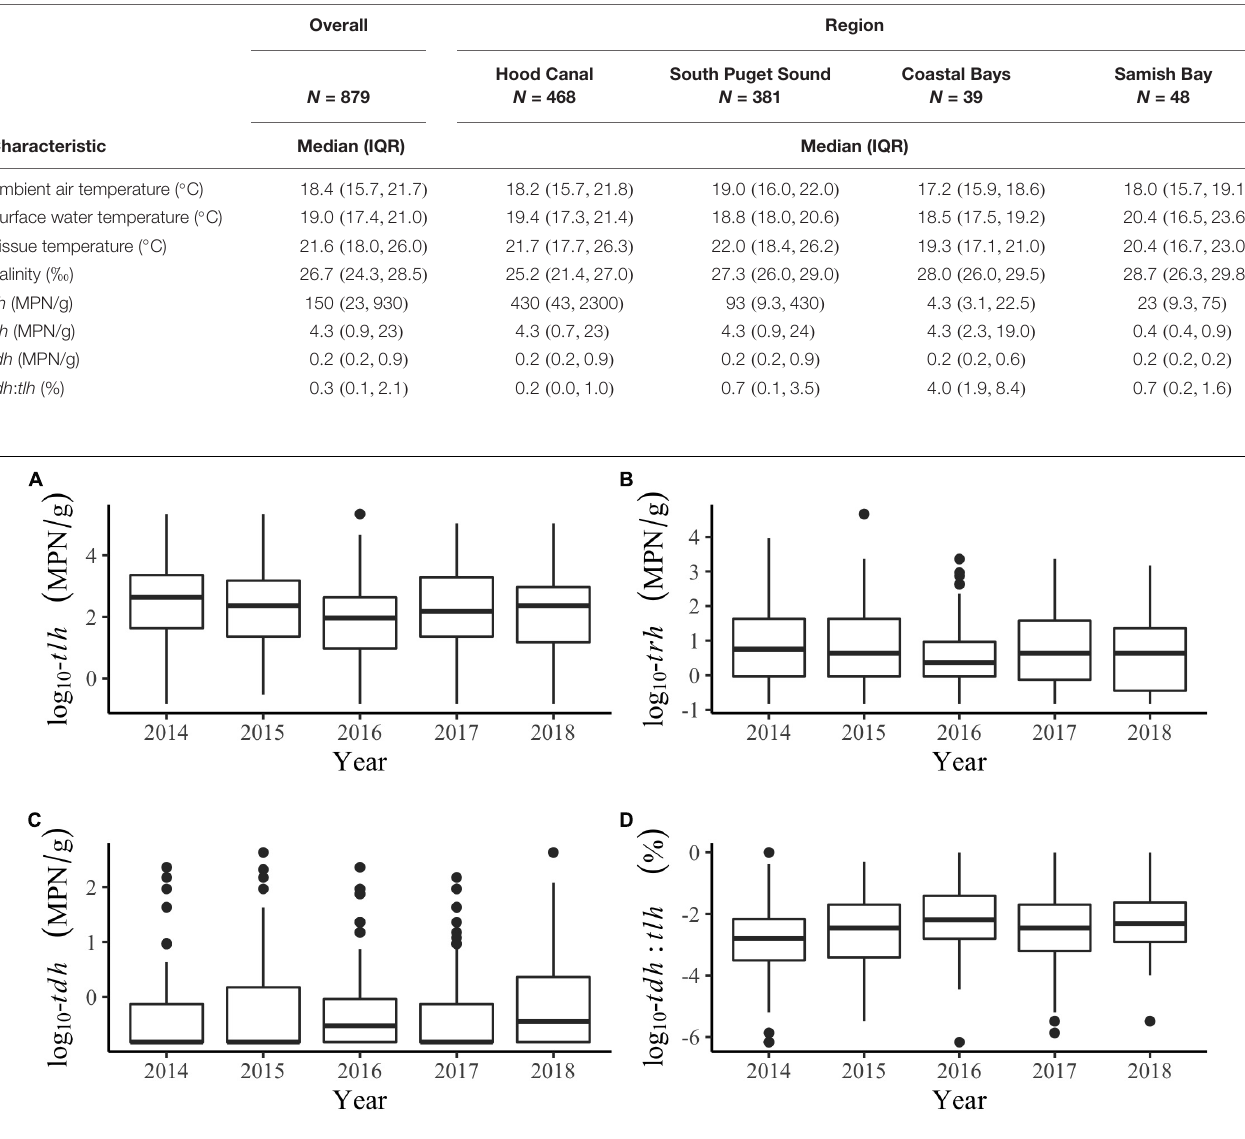
TABLE 1 | Descriptive characteristics of environmental and genetic variables, as well as their variation across sampling regions.